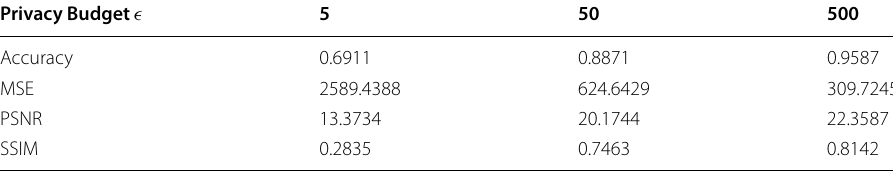
Table 2 MSE, PSNR, SSIM for model perturbation defense with privacy budget